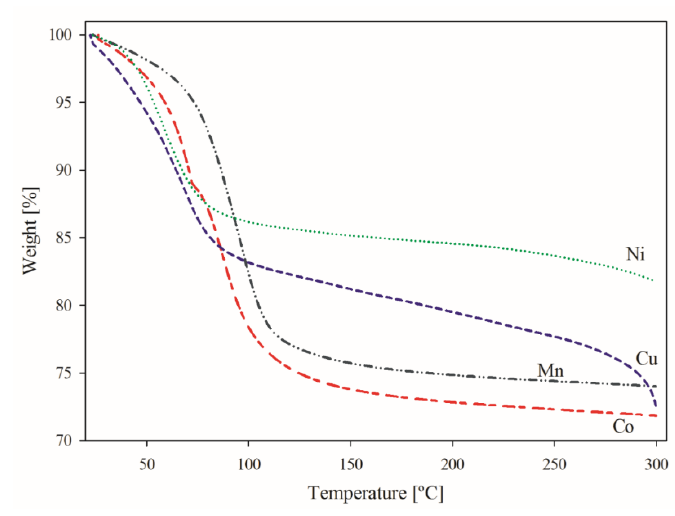
Figure 5. Thermal Gravimetric Analysis (TGA) of Mn(black), Co (red), Ni (green), and Cu (blue).